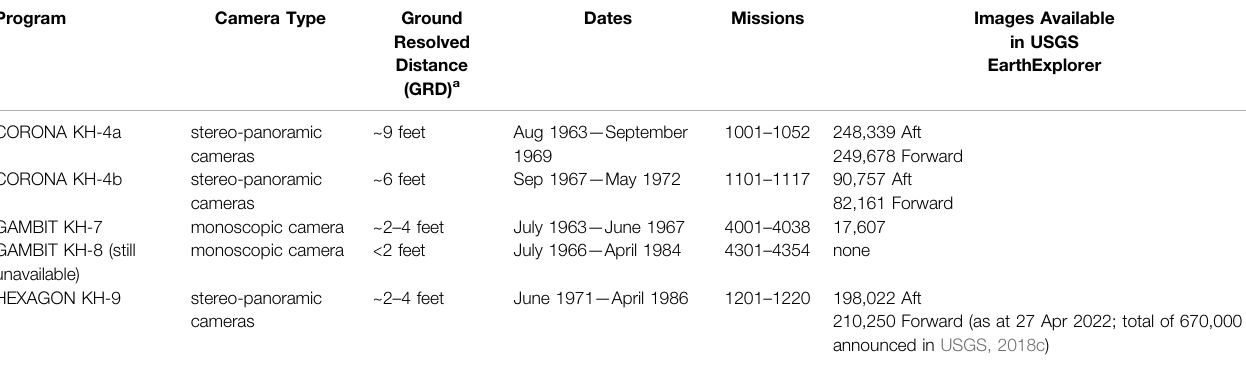
TABLE 1 | Overview of very high resolution historical imagery from United States satellite reconnaissance programs featuring resolutions suitable for tree-level mapping (based on Perry, 1973a; McDonald and Widlake 2012; USGS, 2018a; USGS, 2018b; USGS, 2018c and own research). Scans of the analogue photographs are available through the USGS EarthExplorer for US$ 30 each at fi rst-time order, and may be downloaded free of charge for subsequent users.